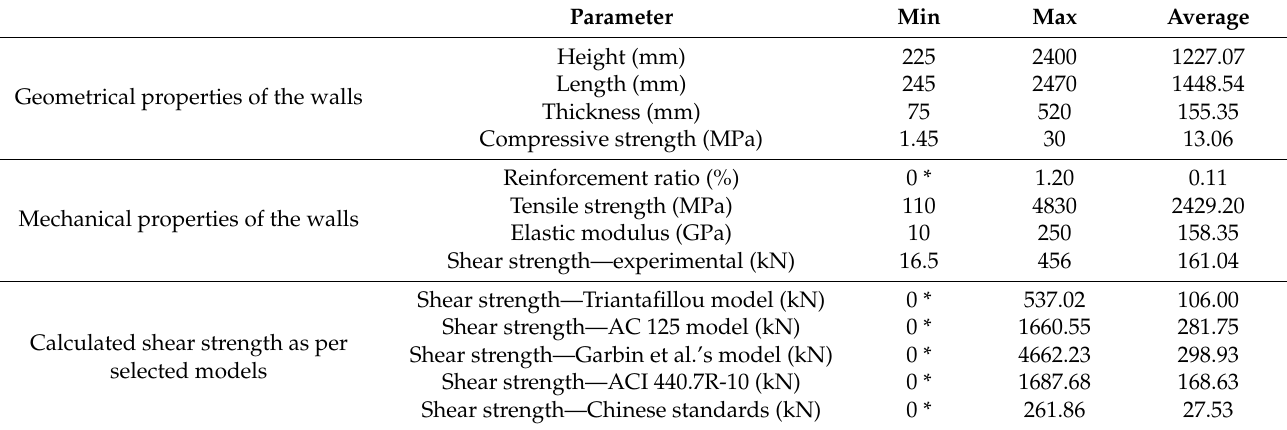
Table 2. General material properties of the FRP-reinforced masonry testing samples included in the